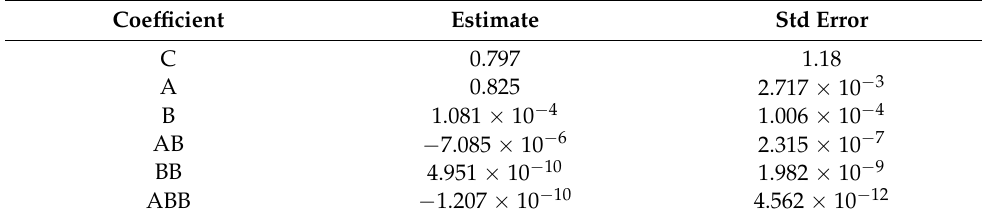
Table 2. Fitting parameters for the regression